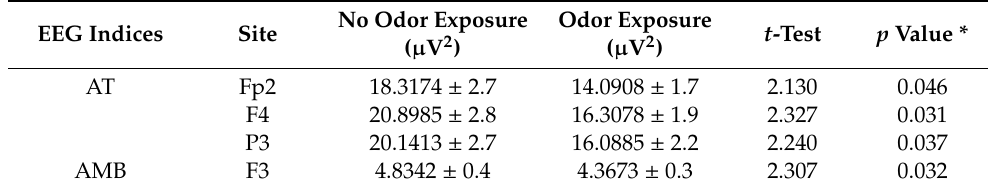
Table 2. Significant changes of EEG power spectrum values during the left nostril inhalation of C10 odor.